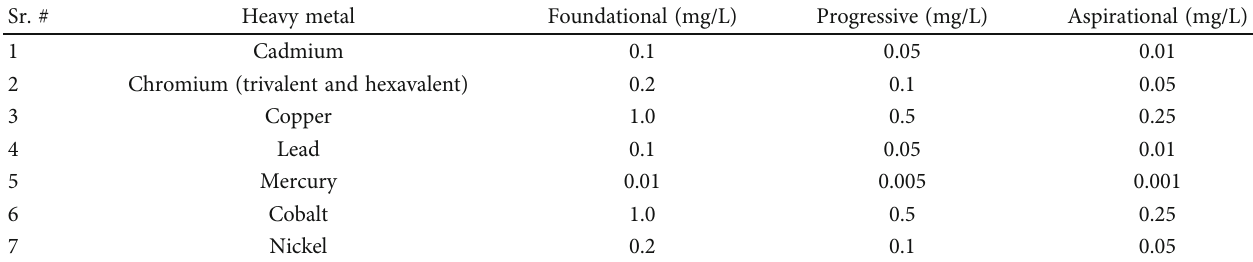
Table 1: Heavy metal limits in wastewater as per ZDHC wastewater guidelines